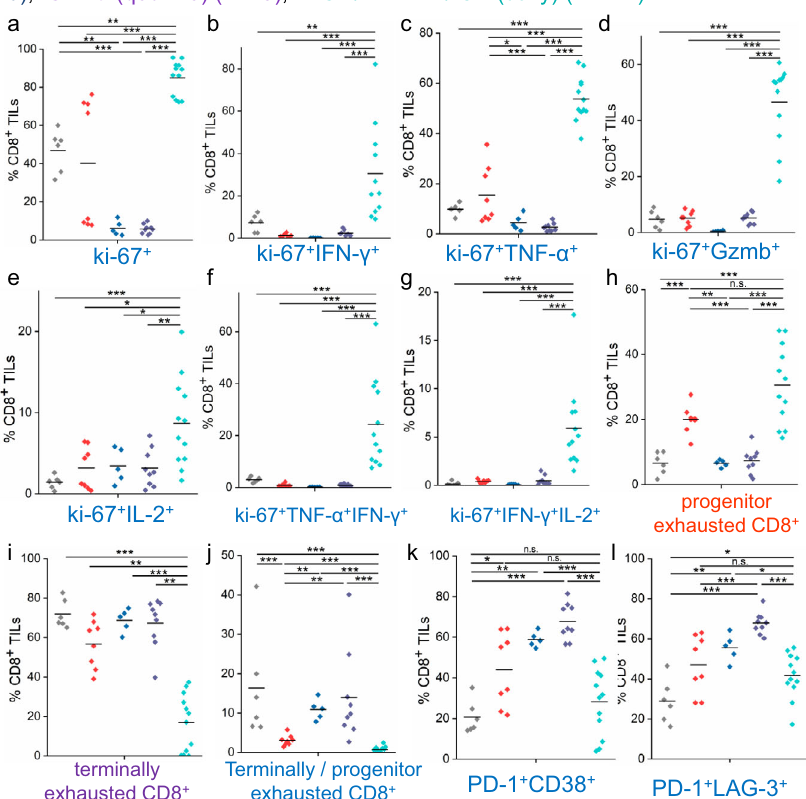
Fig. 7 Analysis of CD8 + TIL subsets that responded to combination therapy administered via IMOD in the treatment of E0771 tumors. The panels show data for E0771 tumors ( n = 5 – 12) in C57BL/6 mice receiving different treatments. a Frequencies of proliferative cells (ki-67 + ) in isolated CD8 + TILs. b – g Frequencies of cytokine production in isolated CD8 + TILs after ex vivo stimulation. The graphs depict frequencies of proliferative ( b ) ki-67 + IFN- γ + , ( c ) ki-67 + TNF- α + , ( d ) ki-67 + Gzmb + , ( e ) ki-67 + IL-2 + , and polyfunctional sets of ( f ) ki-67 + TNF- α + IFN- γ + , and ( g ) ki-67 + IFN- γ + IL-2 + cells in isolated CD8 + TILs. h , i Frequencies of progenitor ( h ) and terminally ( i ) exhausted CD8 + cells in isolated CD8 + TILs. j The ratio between terminally and progenitor exhausted CD8 + TILs. k Frequencies of PD-1 + CD38 + cells in CD8 + TILs. l Frequencies of PD-1 + LAG-3 + cells in CD8 + TILs. Statistical signi fi cance is determined